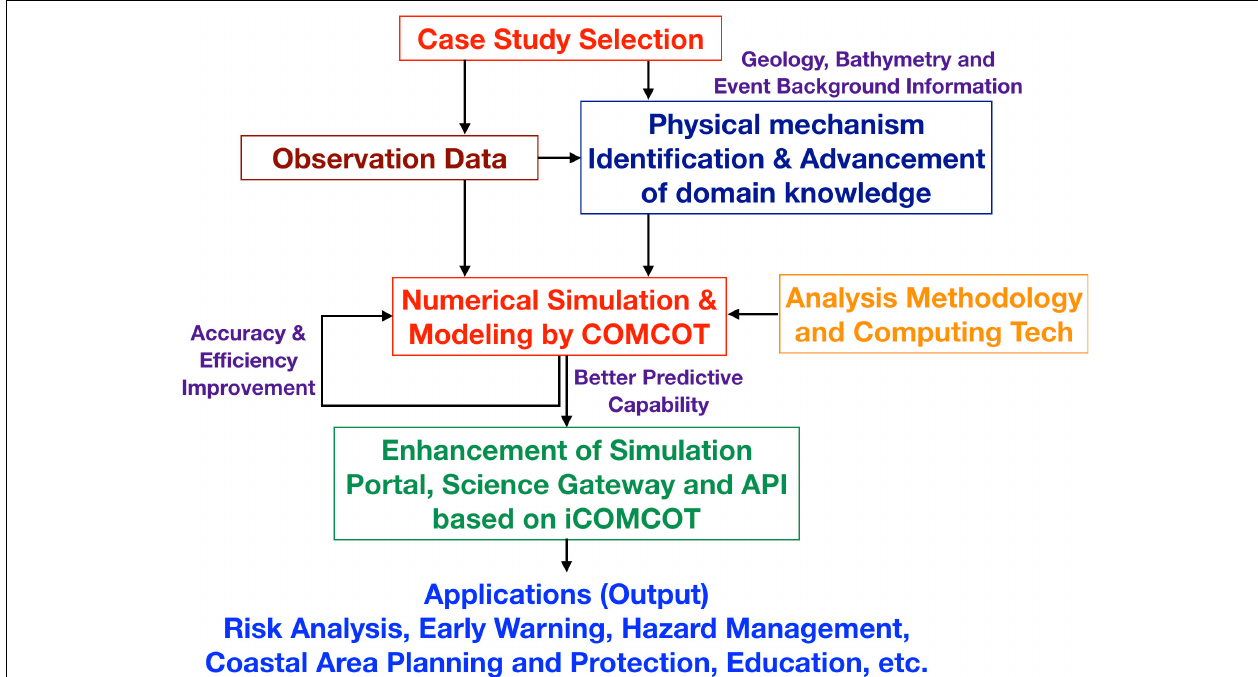
FIGURE 1 | Typical workflow of a tsunami event case study based on the deeper understanding approach. The deeper understanding approach aims to advance the knowledge of the target hazard and develop an accurate numerical simulation model accordingly. The whole lifecycle of the event could be reproduced more accurately than before. All the data, numerical models, simulation portals, and the event simulation are the open accessible outcome of each case study. The numerical simulation model and results could be updated whenever there is new knowledge to the event, new observation data, and new applicable computing technologies.